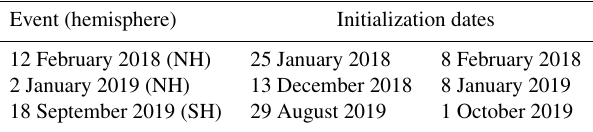
Table 1. Case studies and forecast initialization dates. The nudged- full and control-full ensembles are requested only for the later of the two initialization dates for a given